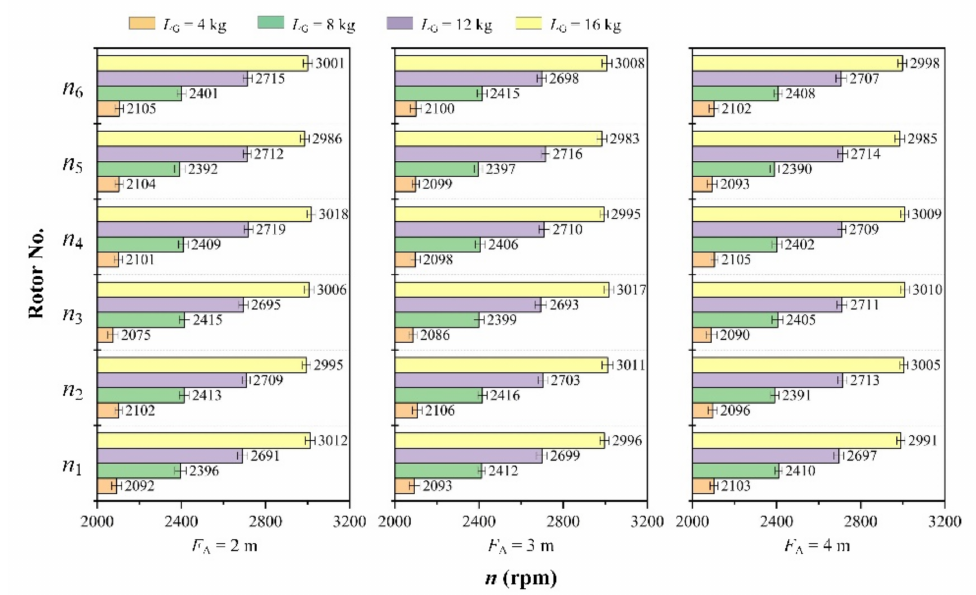
Figure 8. Mean values of measured rotor speed in hovering of the UAV sprayer. The mean ± standard deviation of the rotor speed is presented at each treatment with different loads ( L G = 4, 8, 12, and 16 kg) and flight altitudes ( F A = 2, 3, and 4 m).